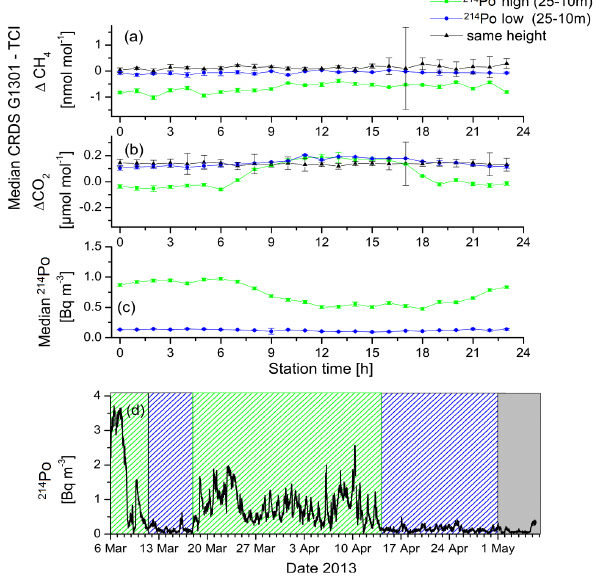
Figure A1: a) Median diurnal CH 4 differences (CRDS G1301 - TCI) and b) median diurnal CO 2 differences (CRDS G1301-TCI) between the CRDS G1301 at 25 m and the TCI at 10 m during periods of high (green) and low (blue) 222 Radon daughter (i.e. 214 Po) activity concentration and c) median diurnal 214 Po activity concentration at about 5 m height a.g.l. during periods of high (green) and low (blue) 214 Po activity concentration (see Figure 8 d). Black symbols in a) and b) show the difference between instruments when measuring at the same height (25 m). Phases of continental (green) and marine (blue) air mass regimes during measurement at different heights are shown in d). The grey background at the end of the period denotes the time period when both instruments measured at the same height.